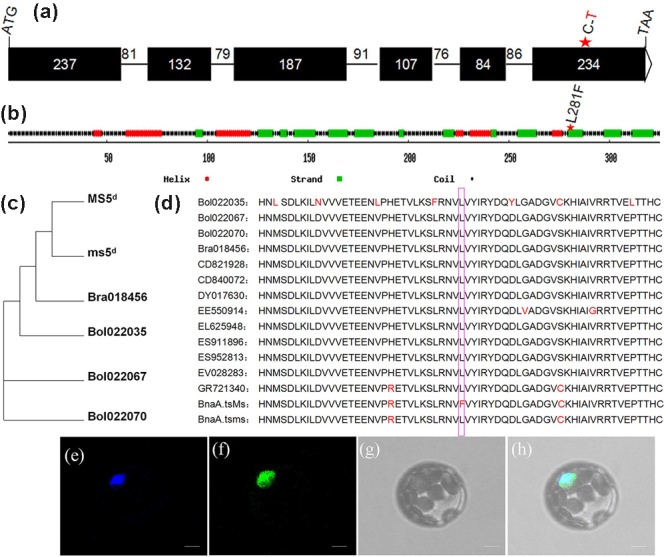
Sequence analysis and subcellular localization of the MS5d protein. (a) Exon/intron structure of MS5d, with six exons (black boxes) and five introns; their corresponding sizes are shown. (b) Deduced MS5d protein structure. (c) Phylogenetic analysis between MS5d homologs identified in Brassica oleracea and B. rapa. (d) Deduced amino acid sequences of MS5d homologs from different Brassica species were aligned with MEGA 4.0. The pink box indicates the L281F mutation. (e) The cyan fluorescent protein (CFP) signal was distributed throughout the protoplast cell after transformation with the control CFP construct. (f) The protoplast showed a green fluorescent signal after transformation with the MS5d-GFP fusion construct. (g) The same protoplast as (e) under bright field. (h) The images in (e–g) were merged. Bars = 10 μm in (e–h).